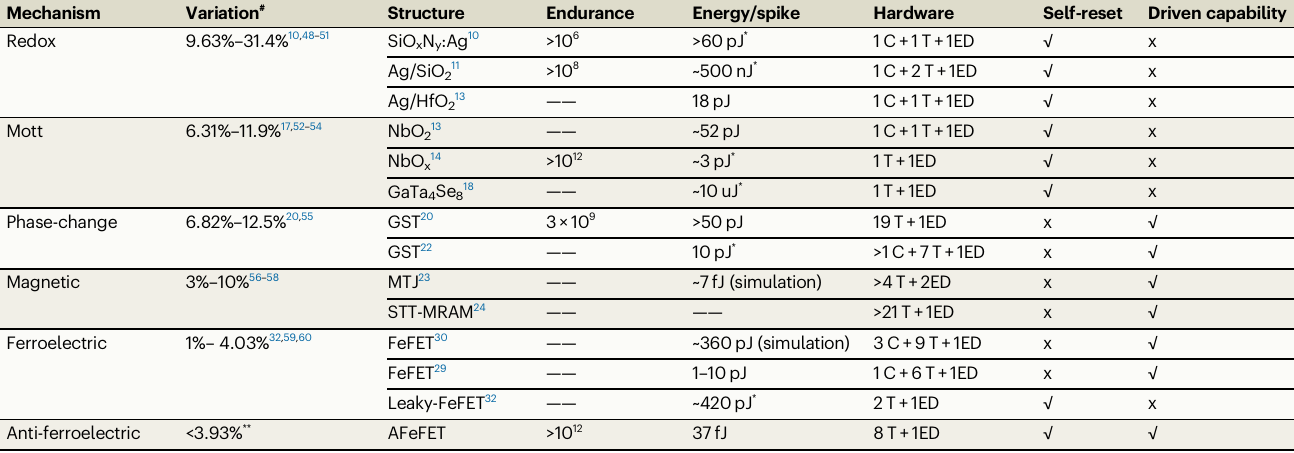
Table 1 | Comparison of various hardware implementations of spiking neurons